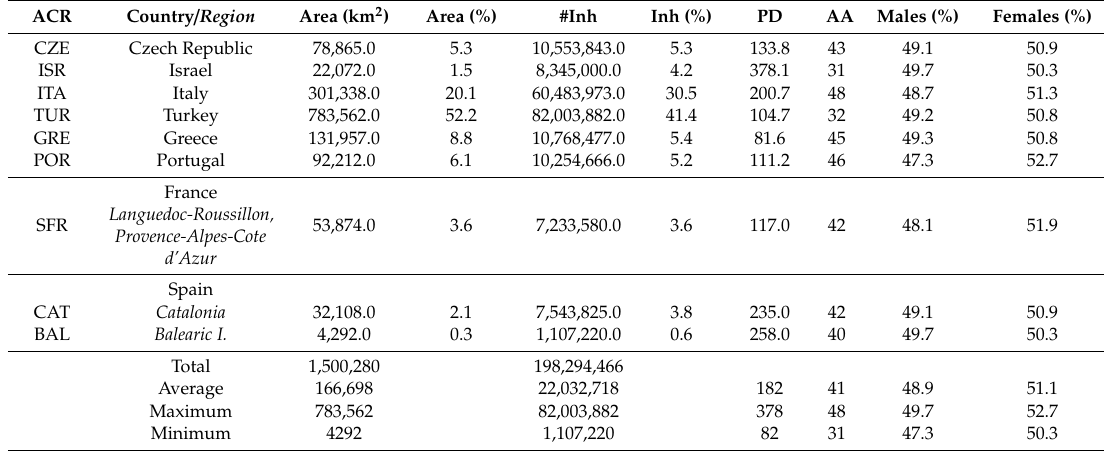
Table 2. Characteristics of the study